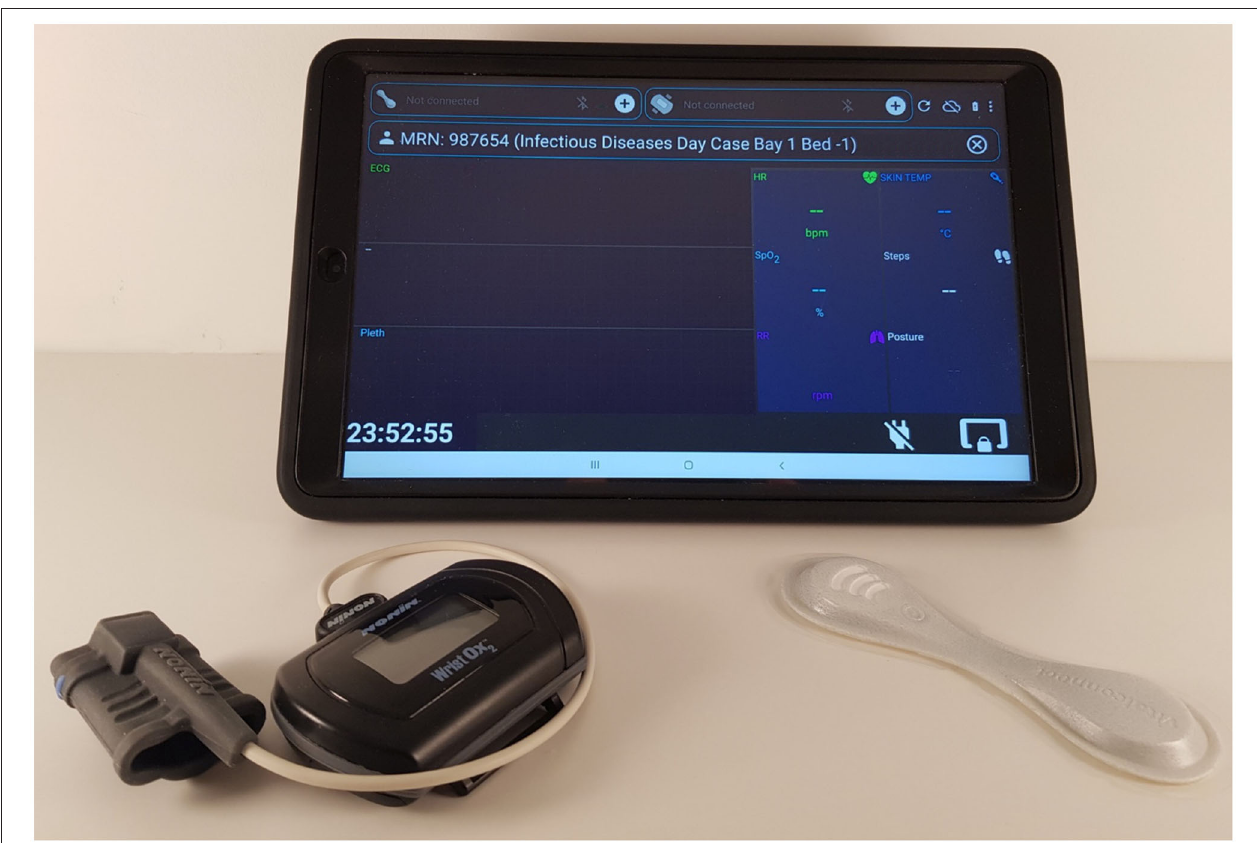
FIGURE 1 | Hardware used to monitor COVID-19 patients on the isolation wards (from left to right): the Nonin finger-worn pulse oximeter, the Samsung Tab A 2019, 10-inch, with front and back protective casing, and the VitalPatch ® .